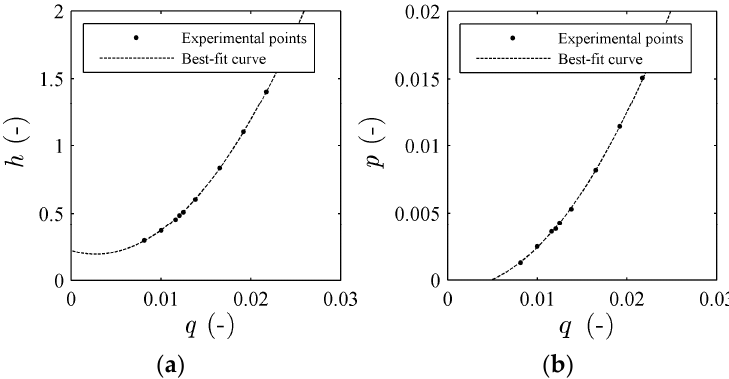
Figure 9. Dimensionless discharge ( q ) against dimensionless head ( h ) ( a ) and power ( p ) ( b ) of PAT HMU50-2/2.